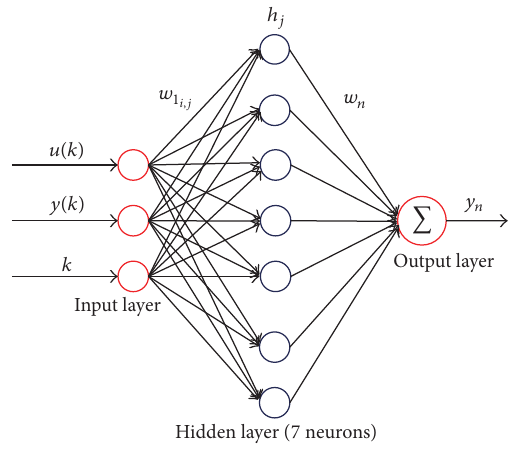
Figure 3: Block diagram of the RBF neural network optimization.